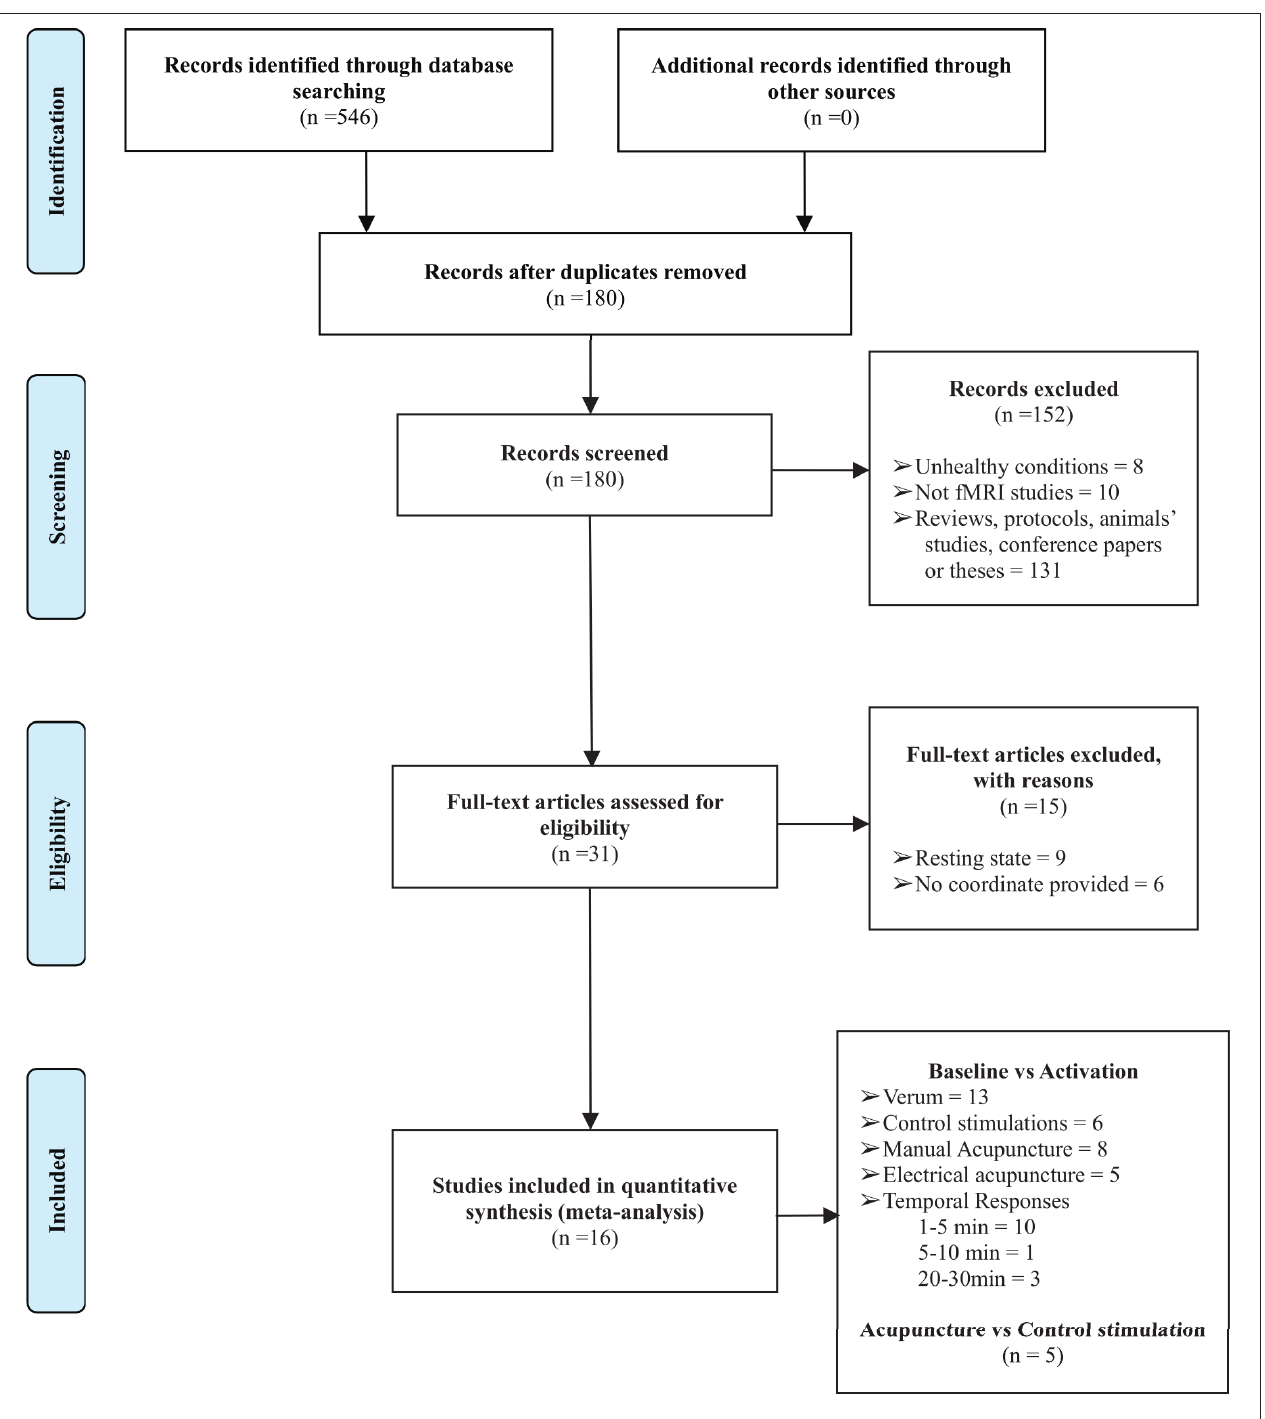
FIGURE 1 | The PRISMA flow diagram of the detailed search and literature selection processes. fMRI, functional magnetic resonance imaging.